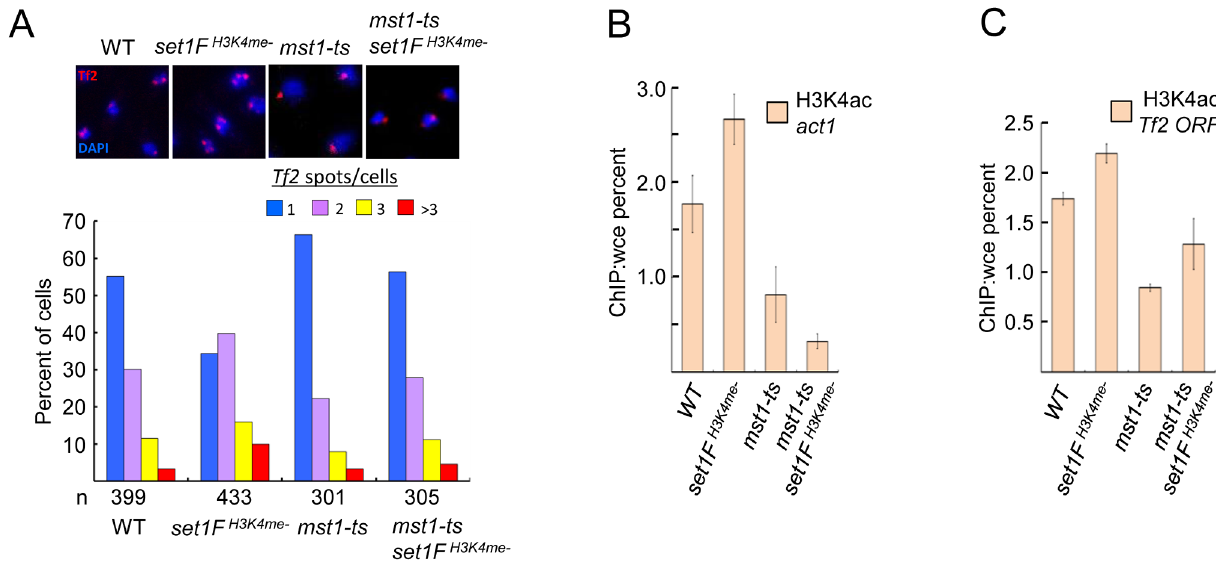
Figure 6. Set1C-mediated H3K4me contributes to the integrity of Tf bodies by antagonizing the H3K4 acetyltransferase Mst1. (A) An mst1 mutation ( mst1-ts ) alleviates Tf body defects seen in an H3K4me mutant strain. Representative FISH images from indicated strains (top panels). Quantitative FISH analysis of observed Tf2 foci/cell in indicated strains (bar graph; bottom panels). Tf2 declustering for set1F H3K4me - strain was significant ( p , 0.005, chi-square test). H3K4ac enrichment at (B) the housekeeping gene act1 and (C) Tf2 ORF in indicated mutant strains was analyzed by ChIP followed by qPCR.